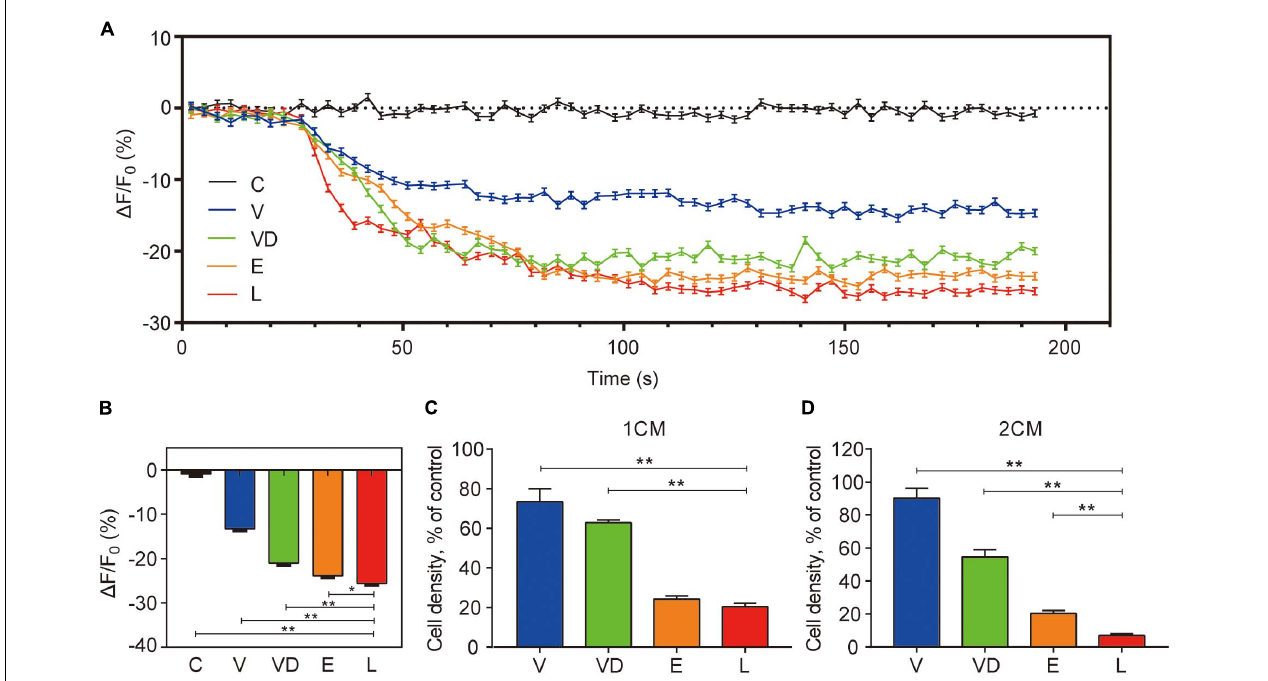
FIGURE 2 | The effect of tested bacteria on the sperm of the intracellular Ca 2 + concentration ([Ca 2 + ] i ) and the ability of penetration into viscous medium. (A) Sperm [Ca 2 + ] i was monitored after loading sperms with 5 µ M Fluo-4 AM, and the fluorescence intensity of the sperm head was visualized and detected before and after adding the different species of bacteria. (B) The statistical analysis of the effects of different species of bacteria on sperm [Ca 2 + ] i at the time frame of 120 s as indicated in (A) . Human sperms were treated with phosphate-buffered saline as control and were exposed to different species of bacteria to assess the penetrating ability of sperms into a viscous medium. Cell density (percentage of control) of (C) 1 cm and (D) 2 cm into the methylcellulose are shown. The initial sperm/bacteria ratio was 1:10. The data represent means ± SD of three independent experiments. * P < 0.05, ** P < 0.01. SD, standard deviation; C, control; V, VNP20009; VD, VNP20009 DNase I; E, E. coli O157:H7; L, L. crispatus